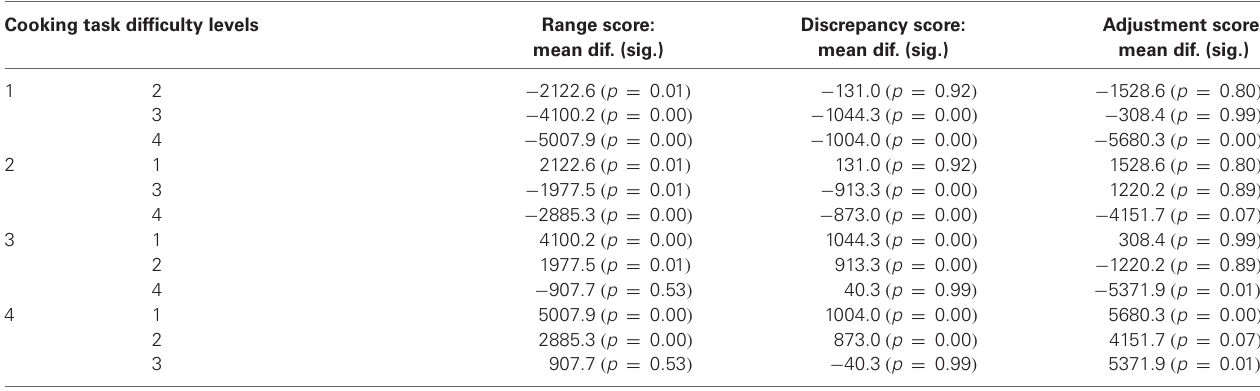
Table 4 | Results of Tukey HSD post hoc analyses across all difficulty levels (1–4), for range, discrepancy and adjustment measures of the cooking task . Cooking task difficulty